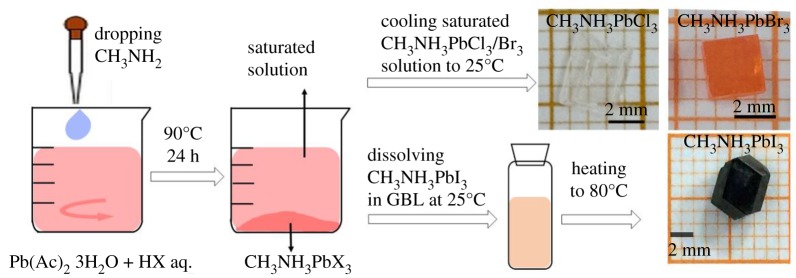
Schematic representation of powder synthesis and single crystals growth of CH3NH3PbX3 (X = Cl, Br, I). CH3NH3PbX3 powders are synthesized through reaction between Pb(Ac)2, CH3NH2 and HX aqueous solution. CH3NH3PbCl3/Br3 crystals are grown by cooling the saturated precursor solution from 90°C to 25°C. CH3NH3PbI3 crystals are grown from the saturated solution of CH3NH3PbI3 powder in γ-butyrolactone (GBL) by gradually heating (from 25°C to 80°C) due to its negative solubility temperature coefficient.